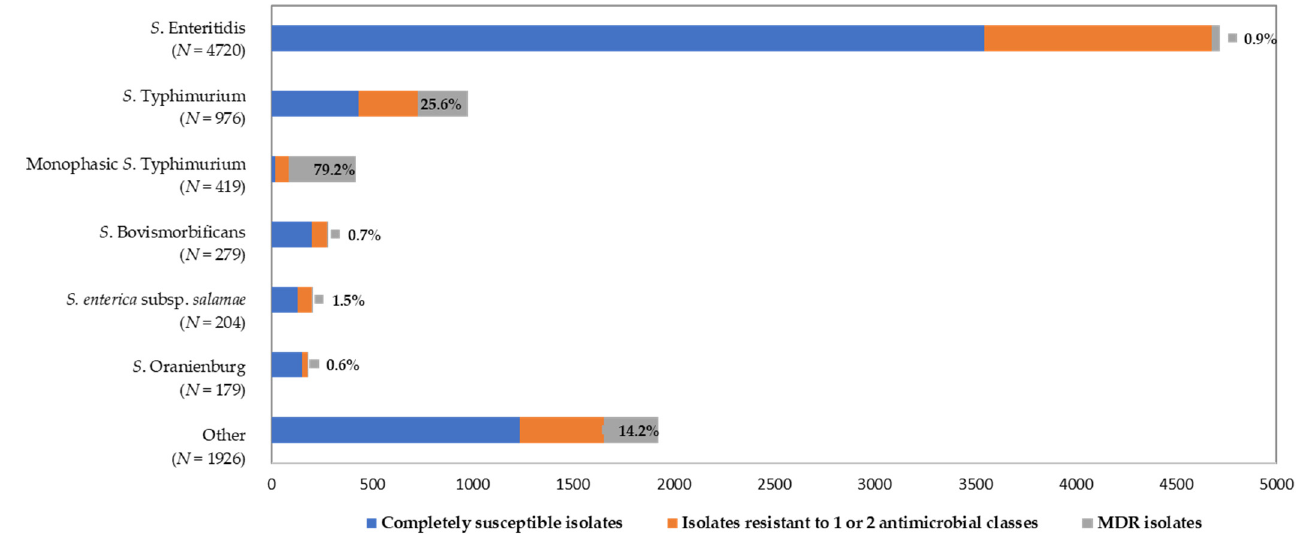
Figure 3. The proportions of the multidrug-resistant (MDR) isolates, isolates resistant to 1 and/or 2 antimicrobial classes and completely susceptible Salmonella spp. isolates from humans in Greece, 2003–2020.